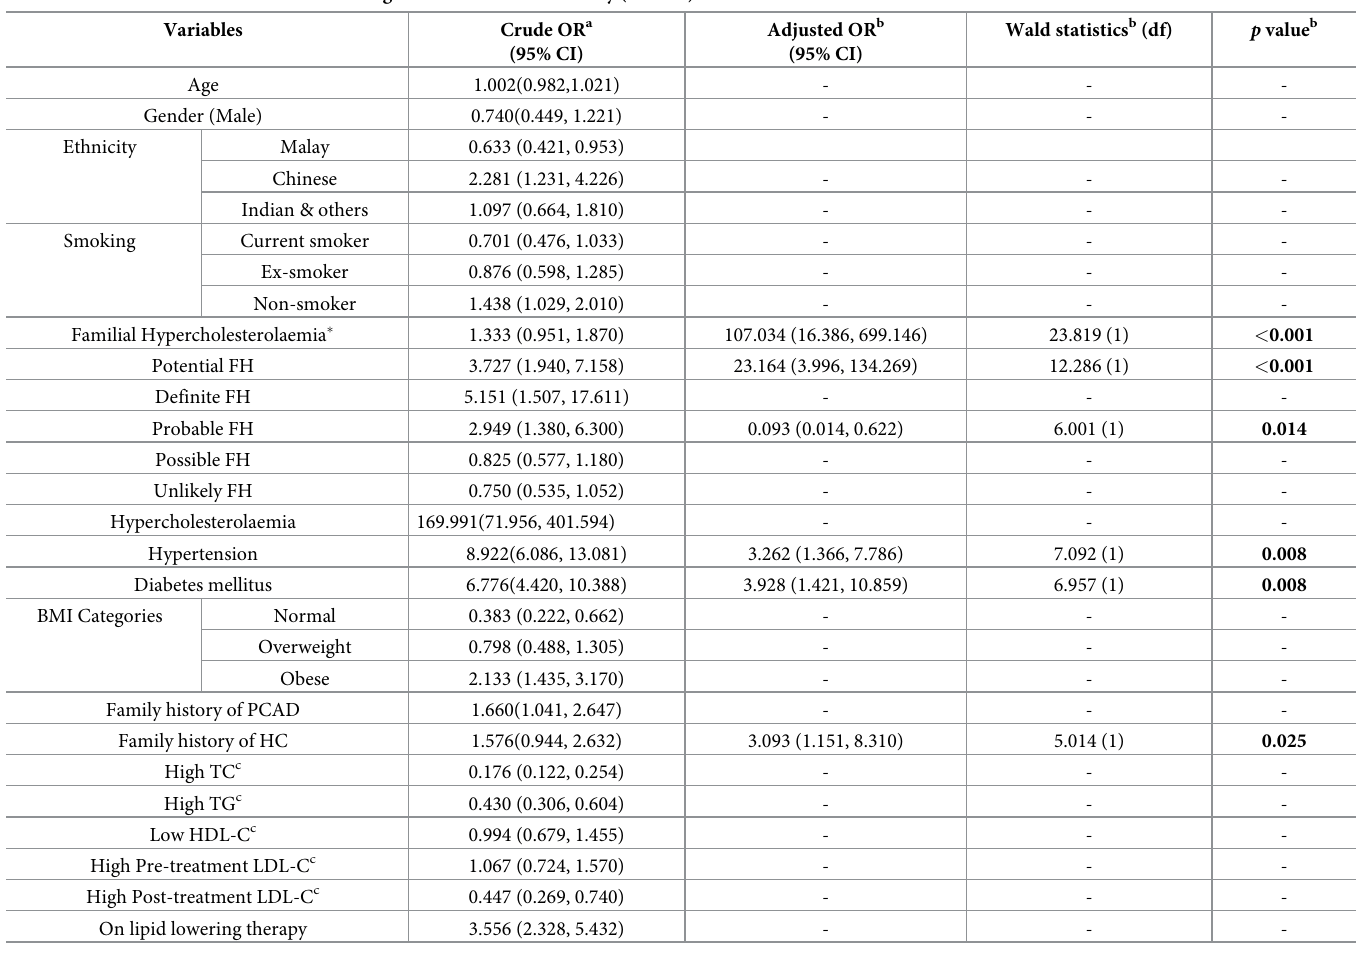
Table 2. Factors associated with PCAD among all individuals in the study (n = 572).